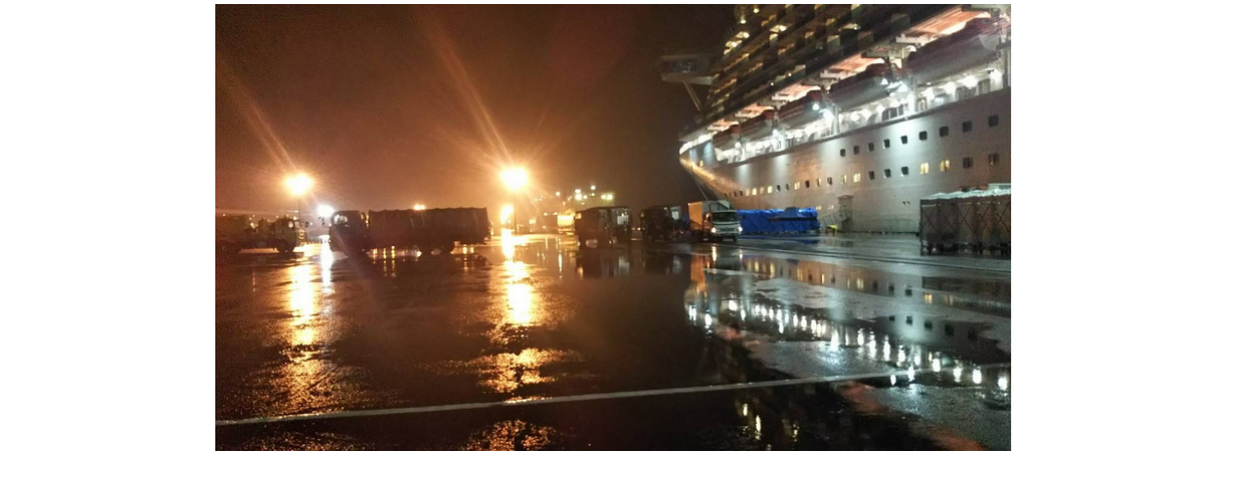
Figure 3. The Diamond Princess was anchored at Daikoku Wharf.